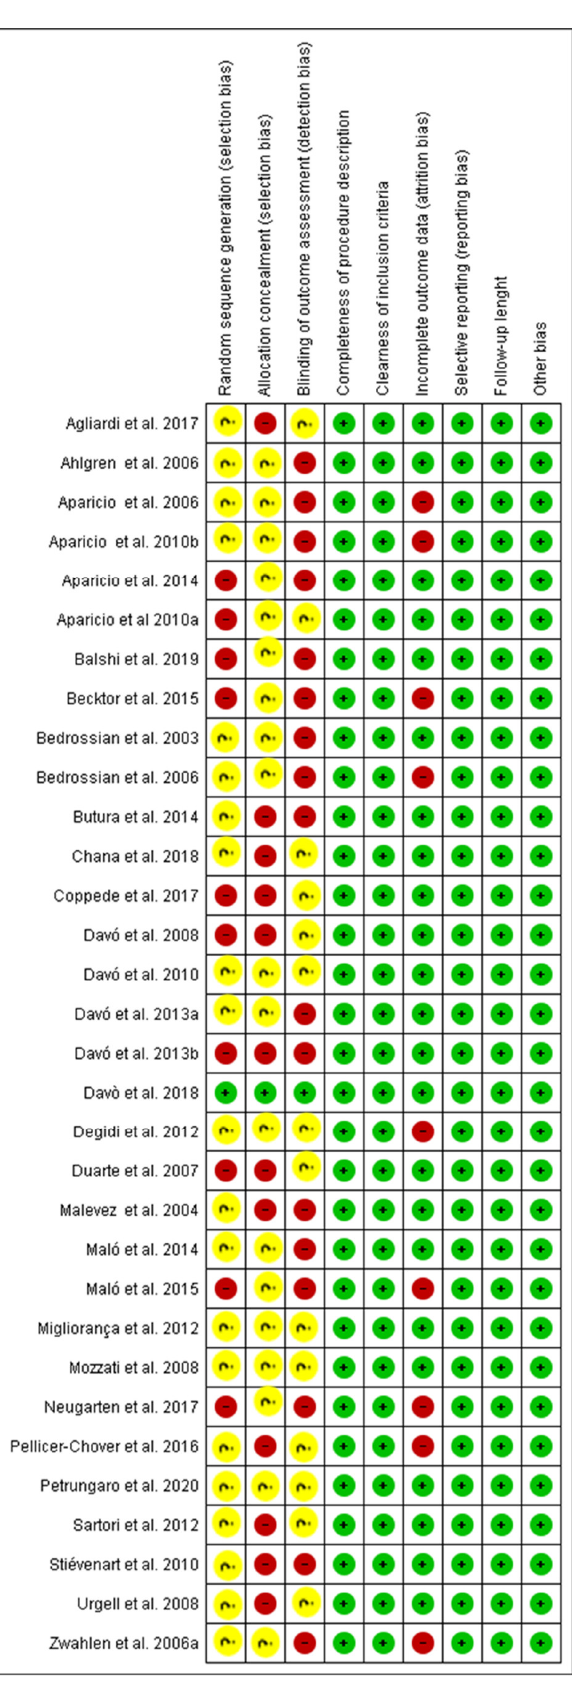
Figure 3. Details of the risk of bias assessment of the studies included.